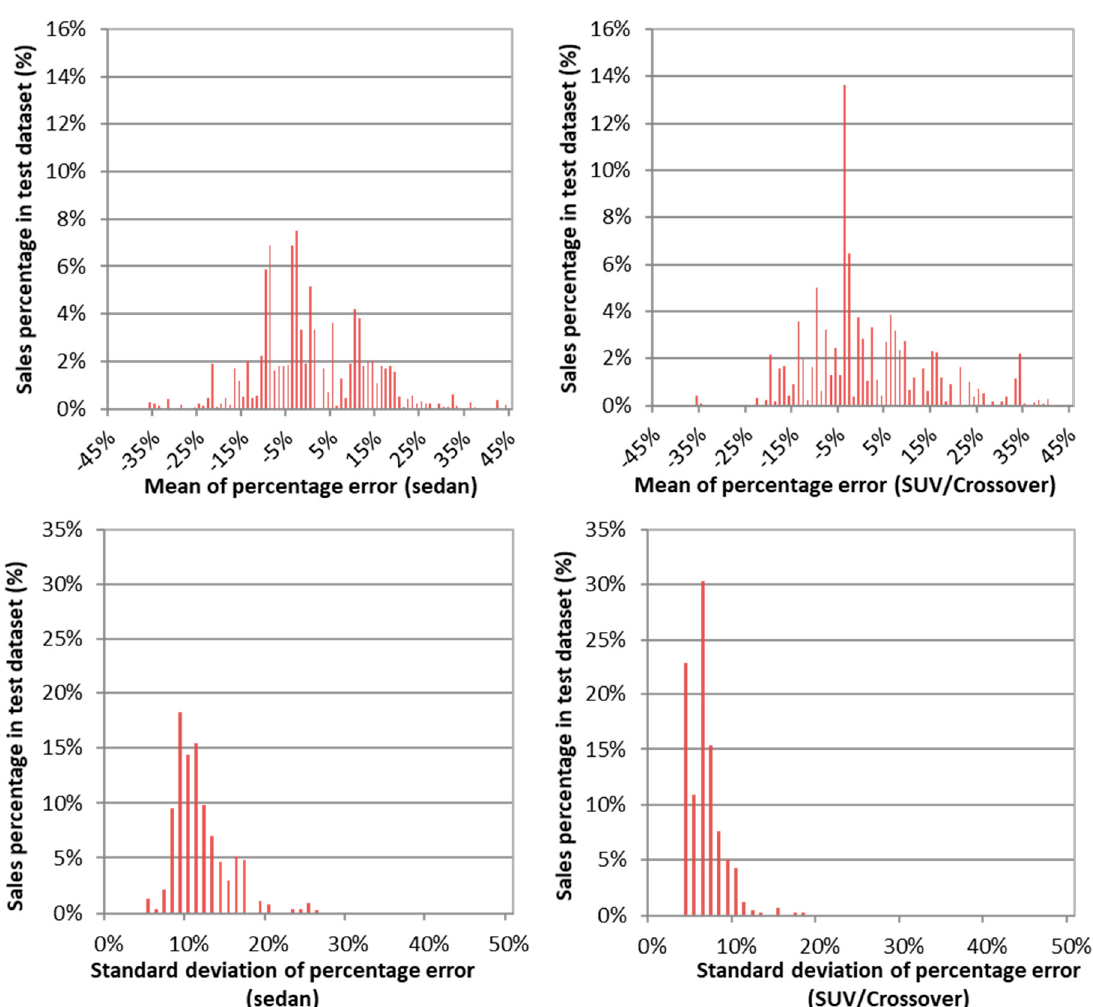
Figure 8. Means and standard deviations of percentage errors in the test datasets.